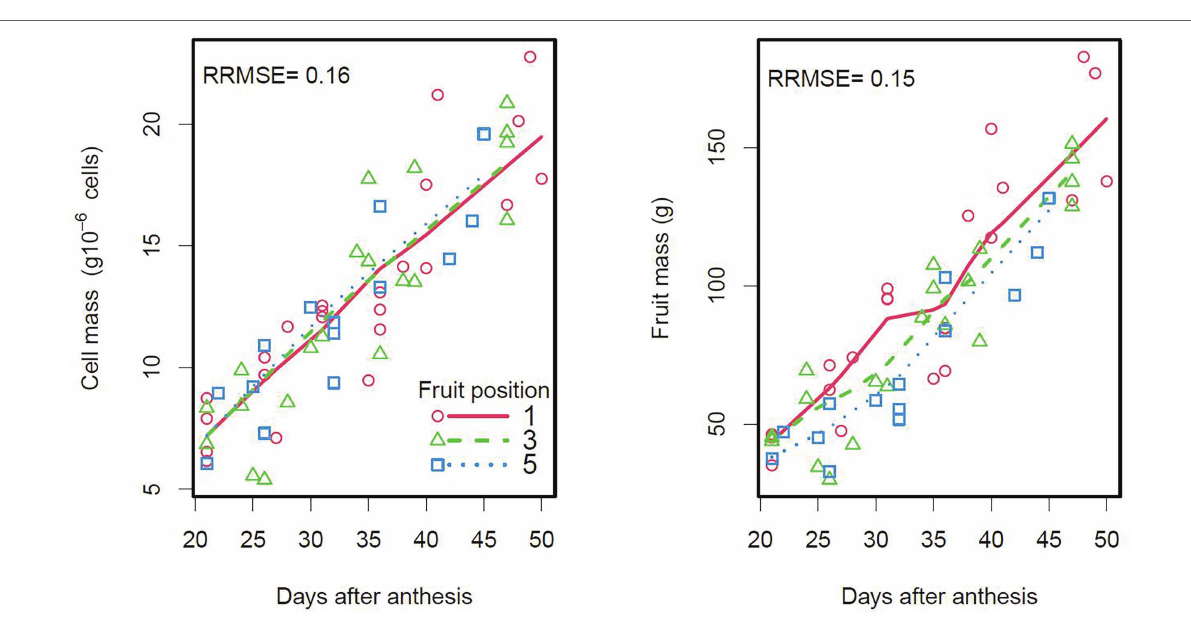
FIGURE 4 | Seasonal variation of cell and fruit masses according to tomato (Raissa Cv.) fruit position in the truss (first, third or fifth fruit from the base of the truss). The points are measured data and the lines are smoothings of DDM outputs. On the right plot, each fruit has a given number of cells (model input based on